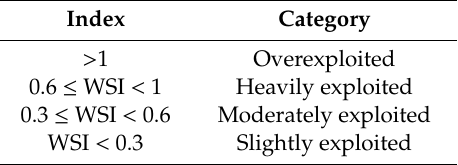
Table 6. Categorization of water scarcity by Water Scarcity Index